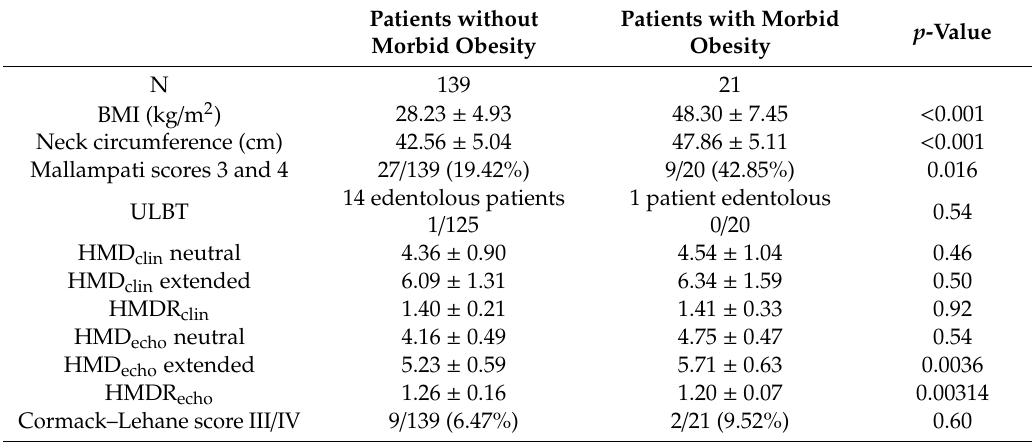
Table 1. Comparative data for patients with and without morbid obesity. N: Number of patients included in each group; BMI: Body mass index; ULBT: Upper lip bite test; HMD: Hyomental distance; clin: Clinical measurement; echo: Ultrasound measurement; p -values derived from t-test for continuous data and Chi-squared test for frequencies.